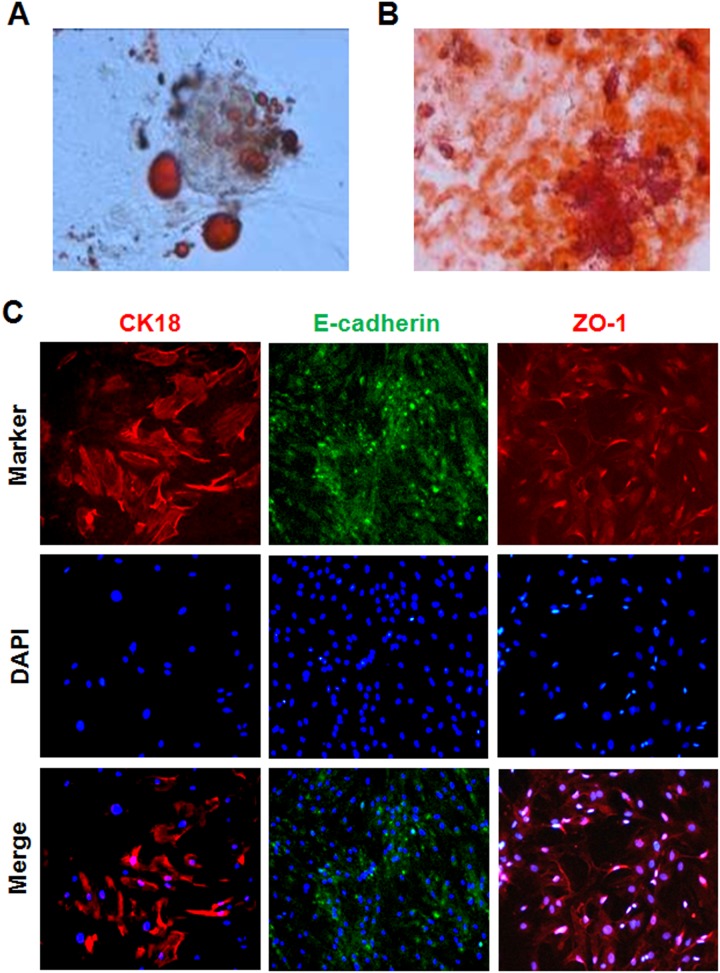
Determination of KSC differentiation abilities.(A,B) KSC adipogenic and osteogenic differentiation was assessed by (A) oil red O and (B) alizarin red staining, respectively (Magnification: ×200). (C) Epithelial cell differentiation was examined by immunofluorescence staining for the mature epithelial cell markers CK18 (red, ×200), ZO-1 (red, ×200), and E-cadherin (green, ×100). Nuclei are counterstained with DAPI (blue).